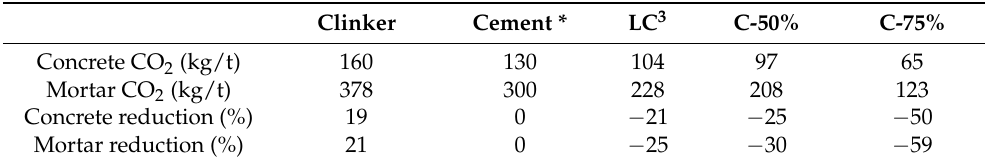
Table 4. CO 2 expressed in kg/t and as percentage for mortar and concrete made with different kinds of binders.